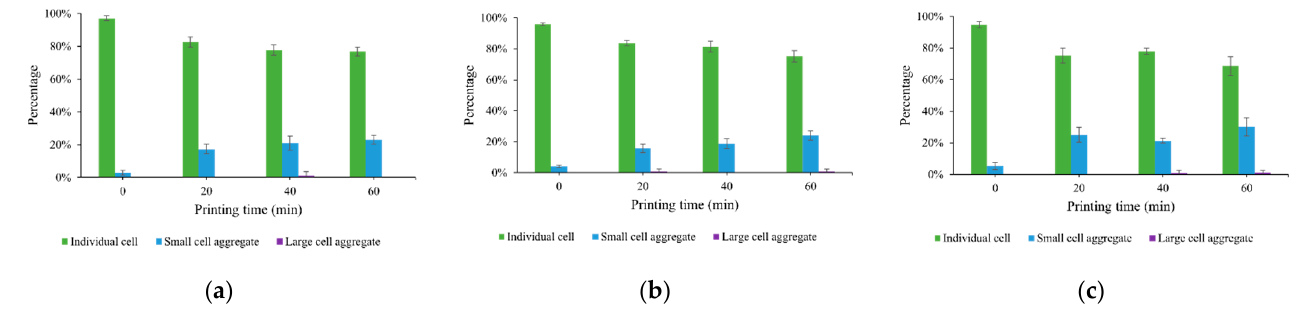
Figure 7. Cell existing forms at the bottom of the bioink reservoir using the bioink composed of 3% ( w / v ) sodium alginate and a cell concentration of ( a ) 1 × 10 6 cells/mL, ( b ) 1.5 × 10 6 cells/mL, and ( c ) 2 × 10 6 cells/mL.